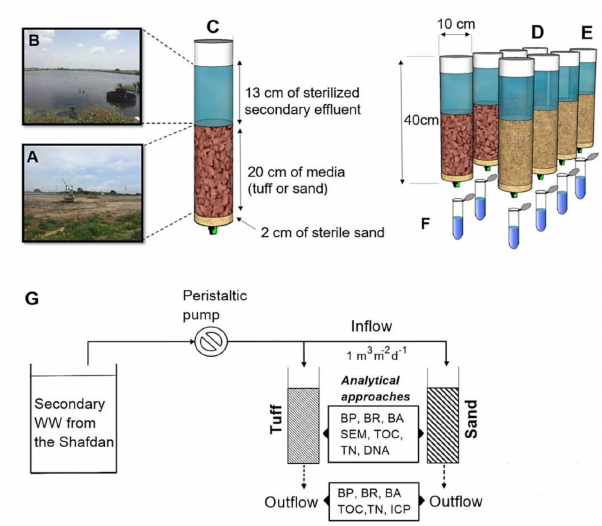
Figure 1. Experimental microcosm schematics. Maturated media samples (tu ff or sand) were excavated (30 cm deep) from an infiltration pond ( A ) and placed in transparent Perspex ® columns. Concurrently, the secondary e ffl uent was collected from an adjacent infiltration pond ( B ) and added to the columns. The content overview and respective amounts of the media placed in each column are depicted in the enlarged column ( C ). Quadruplicates of maturated tu ff ( D ) and sand ( E ) were tested after 48 h (Table 1) of sterile secondary WW inflow at a flux similar to that measured in the Shafdan Soil aquifer treatment (SAT) (1 m 3 m − 2 d − 1 ). The outflow following media filtration (50 mL) was collected and analyzed to